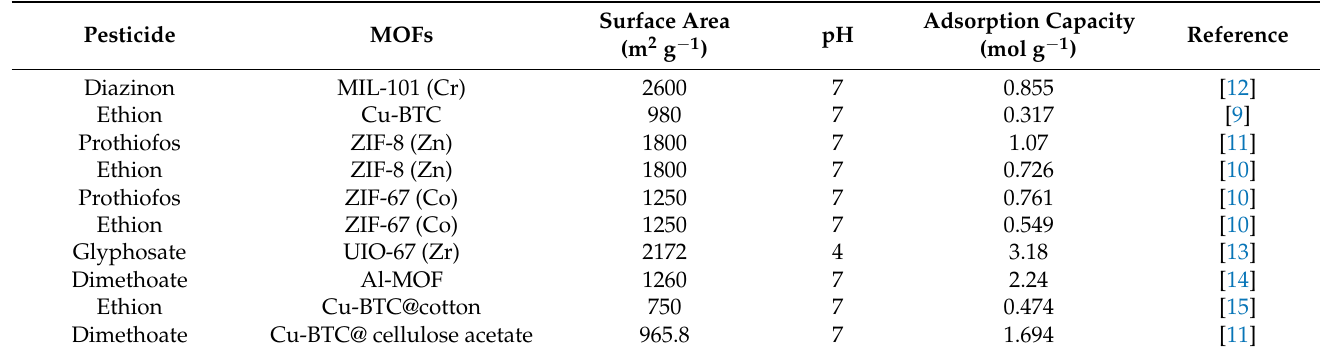
Table 1. Adsorption of pesticides from wastewater with